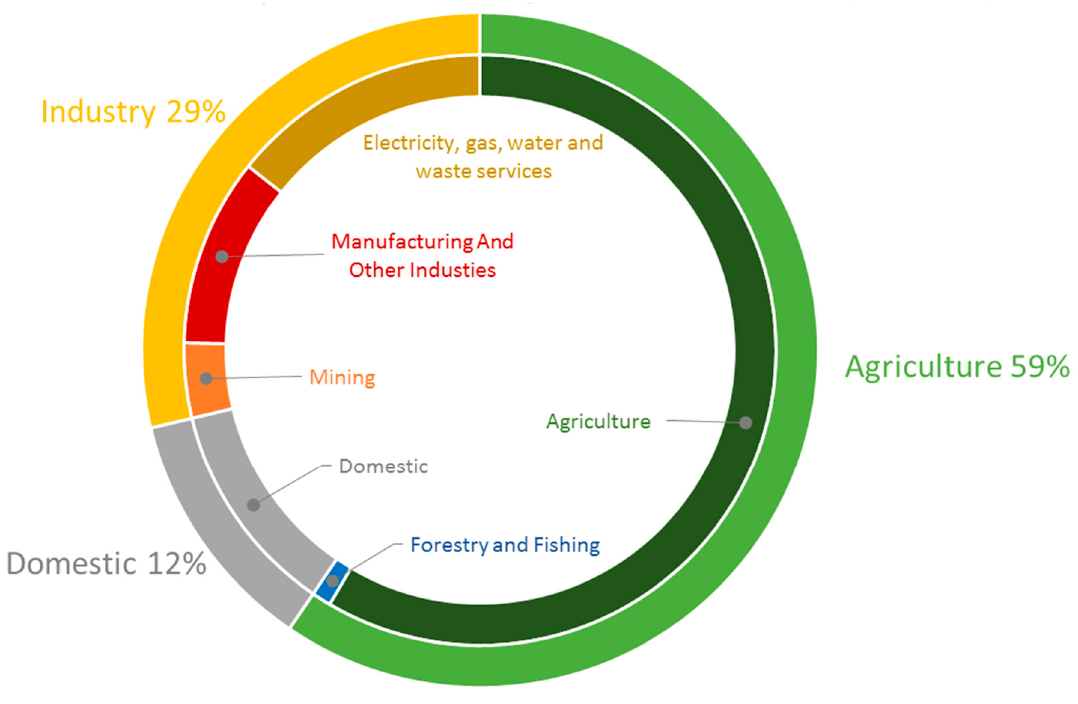
Figure 1. Water consumption share in major sectors 2015–2016 (Data source: Australian Bureau of Statistics, 2017).